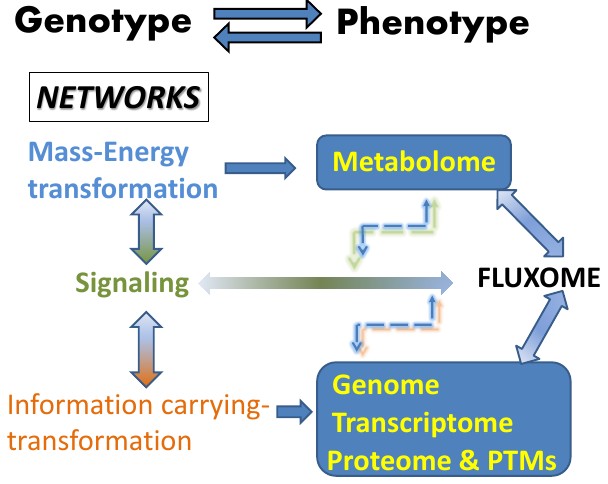
Figure 1. The fluxome integrates the outcomes of mass-energy/information and signaling networks. Signaling networks connect and modulate the mass-energy-information